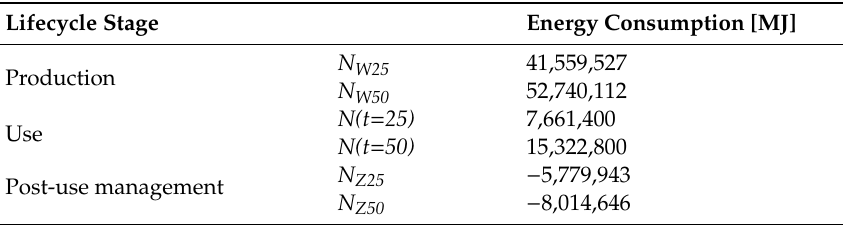
Table 5. Energy costs determined with the use of the LCA method in the material stages of a 25 years and 50 years wind power plant lifecycle (cumulative energy demand (CED)